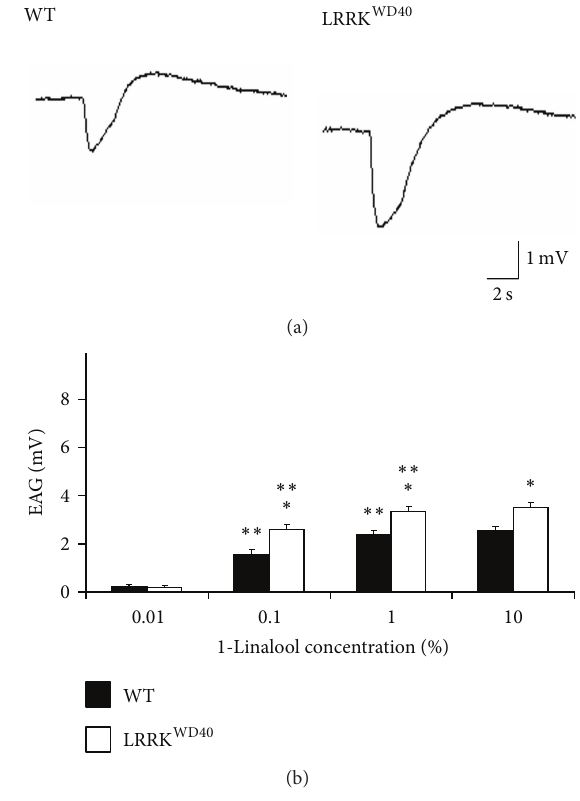
Figure 1: Electroantennogram (EAG) responses to 1-hexanol. Sam- ple EAG recordings (a) and EAG amplitude values (b) elicited by stimulation with the different concentrations of 1-hexanol (0.01, 0.1, 1, and 10% v/v) in male antennae of WT and LRRK WD 40 mutant flies. Mean values + SEM from 24–26 antennae for each stimulus concentration and insect sample. ∗ and ∗∗ indicate significant differences ( 𝑃 < 0.05 ; HSD post hoc test subsequent to one- way ANOVA or repeated-measures ANOVA) from WT and from preceding concentration of same stimulus, respectively.